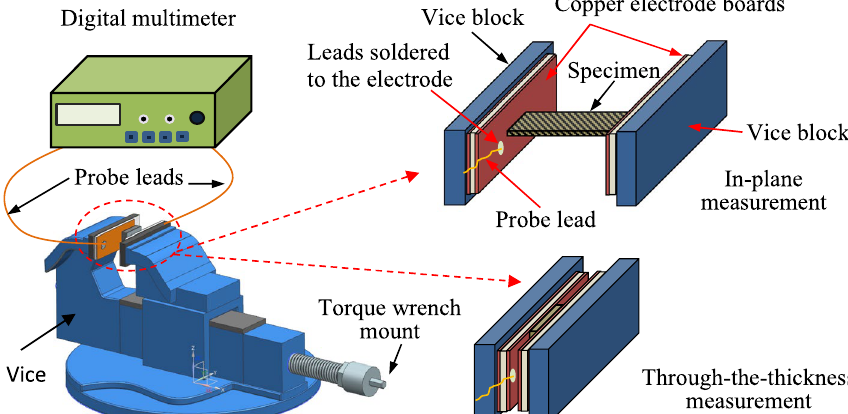
Fig. 2 Two-probe method for measurement of volume electrical